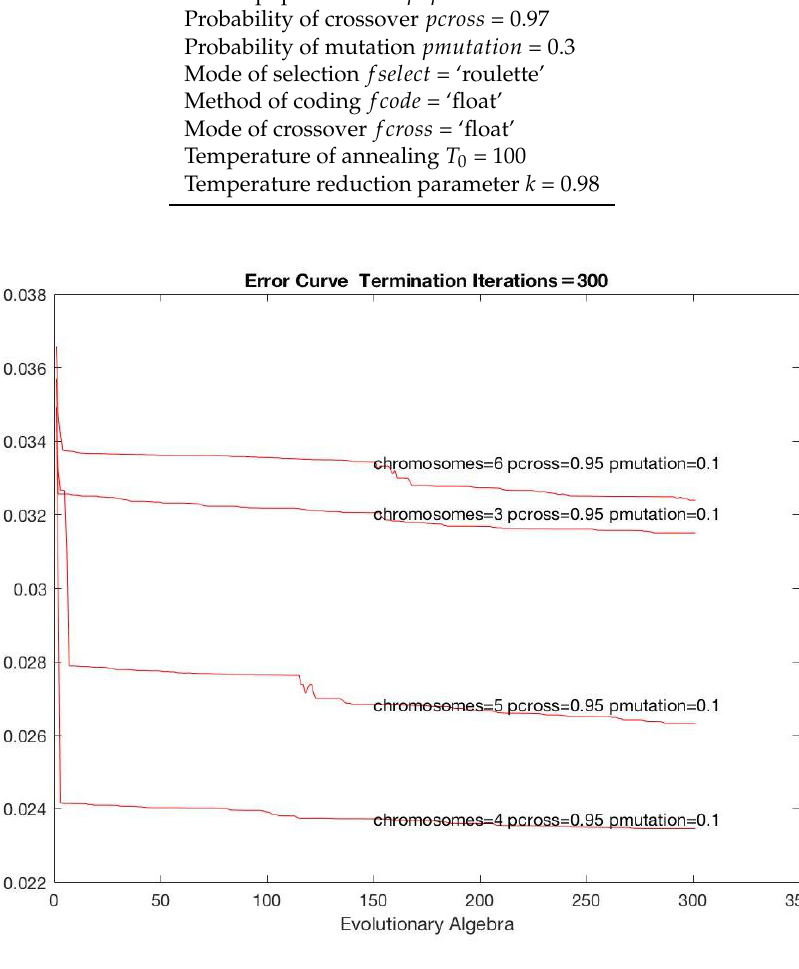
Figure 5. Effect of chromosome number on the objective function